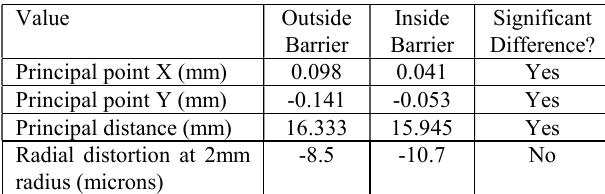
Table 2. Selected camera calibration parameters for camera